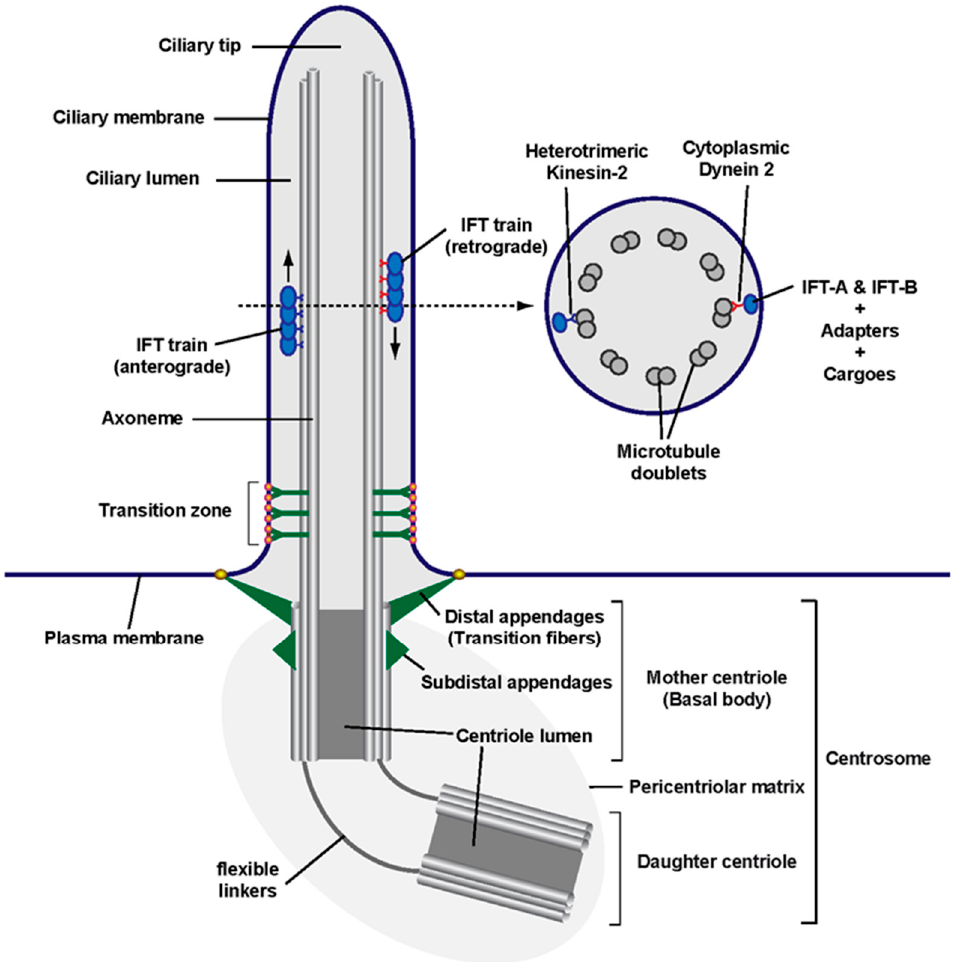
Figure 1. Anatomy of a primary cilium: Schematic of a primary cilium and its parts, including the centrosome at its base, from whose mother centriole (known as basal body in the context of a cilium) emanates the ciliary axoneme (i.e., its microtubule shaft). The region separating the ciliary compartment from the rest of the cell contains two main structures: the mother centriole’s distal appendages (known as transition fibers in a ciliary context) and the transition zone, with its distinctive Y-shaped linkers ending in bead-like membrane particles known as the ciliary necklace. Along the axoneme travel intraflagellar transport (IFT) trains, which move towards the ciliary tip (anterograde) or the ciliary base (retrograde). As shown in the cross section (right), the primary cilium axoneme consists of nine microtubule doublets but lacks structures found in motile cilia and flagella (such as a central microtubule pair, radial spokes and axonemal dynein arms). As indicated, IFT trains are multiprotein assemblies consisting of microtubule motors and IFT complexes IFT-A and IFT-B. These protein complexes can associate with cargo directly (as is the case for α / β -Tubulin dimers) or indirectly through adapters such as the BBSome, which connects IFT complexes to membrane cargoes.